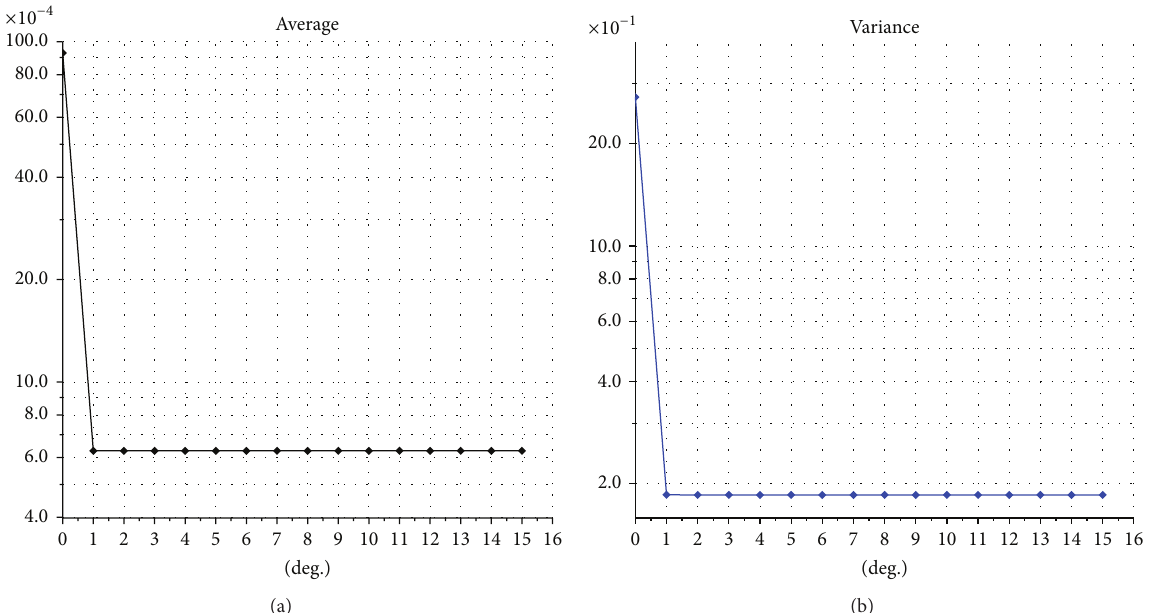
Figure 13: Semilogy scale plot of the absolute error of mean (a) and variance (b) computed via PCE of CIR model at time 𝑇 = 1 , with parameters 𝛼 = 0.1 , 𝛽 = 0.2 , 𝜎 = 0.15 , and 𝑅 0 = 110 .